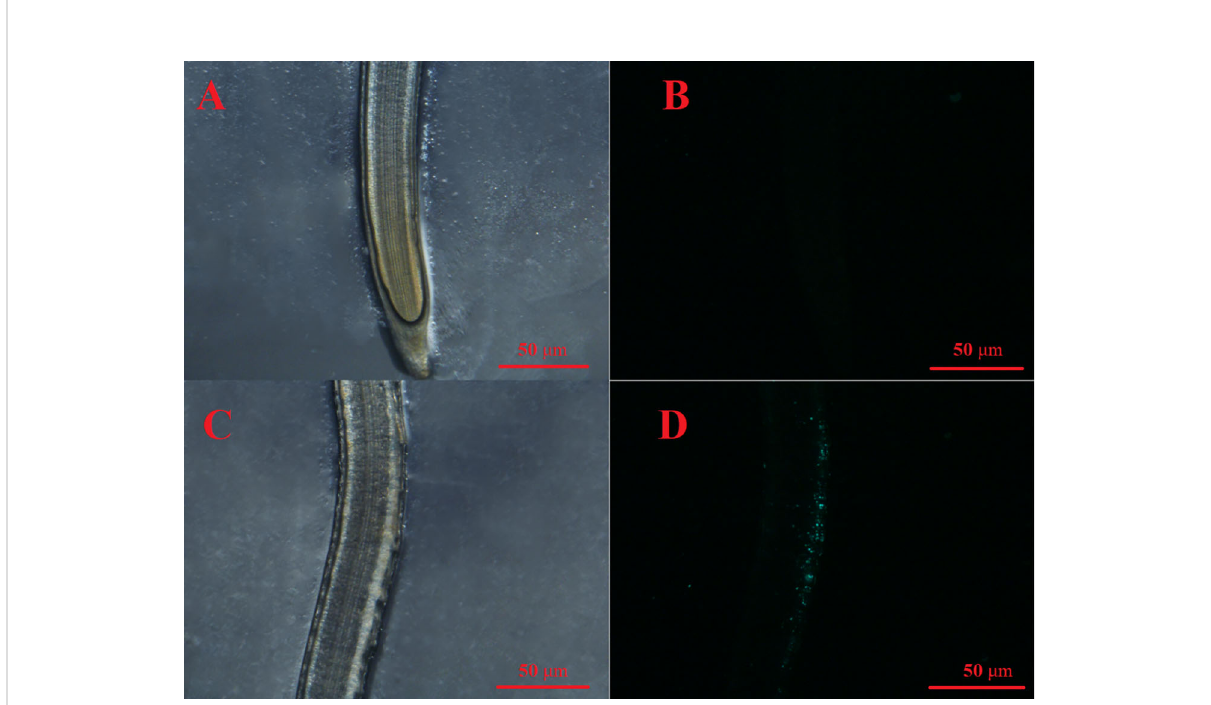
FIGURE 6 Seedling roots with 1 mg/L fl uorescent PS MPs (0.1 m m) after 3 d of exposure. (A) : Root tip under normal light. (B) : Fluorescent signal in the same root tip shown in (A, C) Middle segment of a root under normal light. (D) : Fluorescent signal in the middle segment of the same root shown in (C)